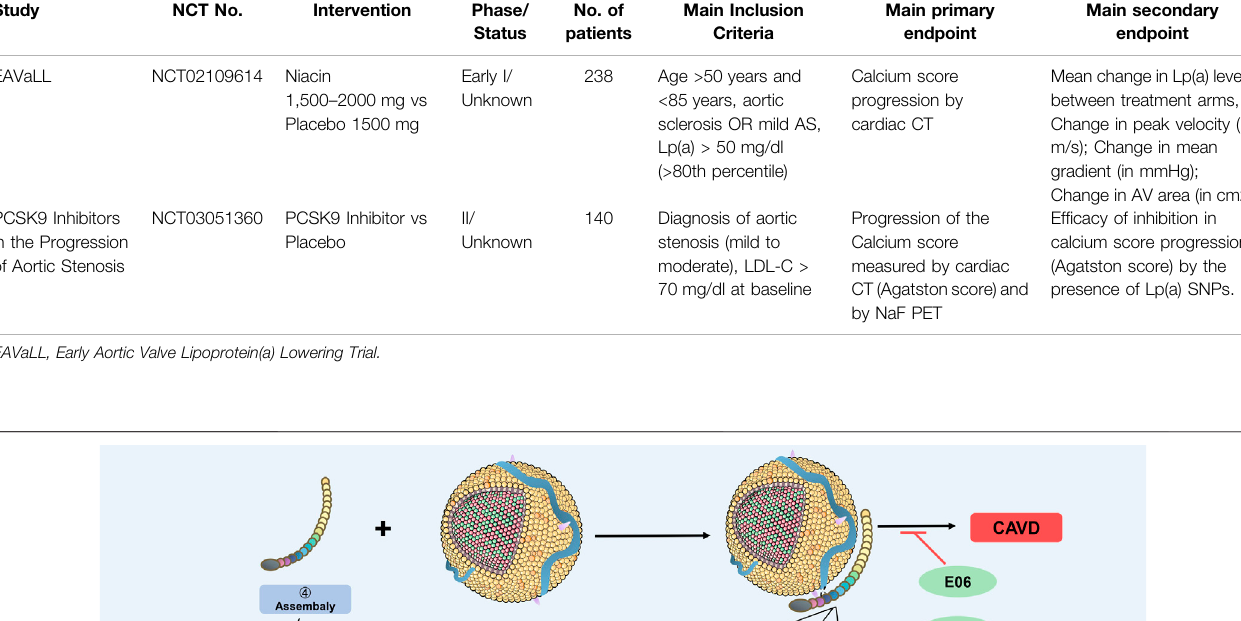
TABLE 3 | Trials of medical therapy for treatment of Lp(a)-mediated CAVD. Study NCT No.